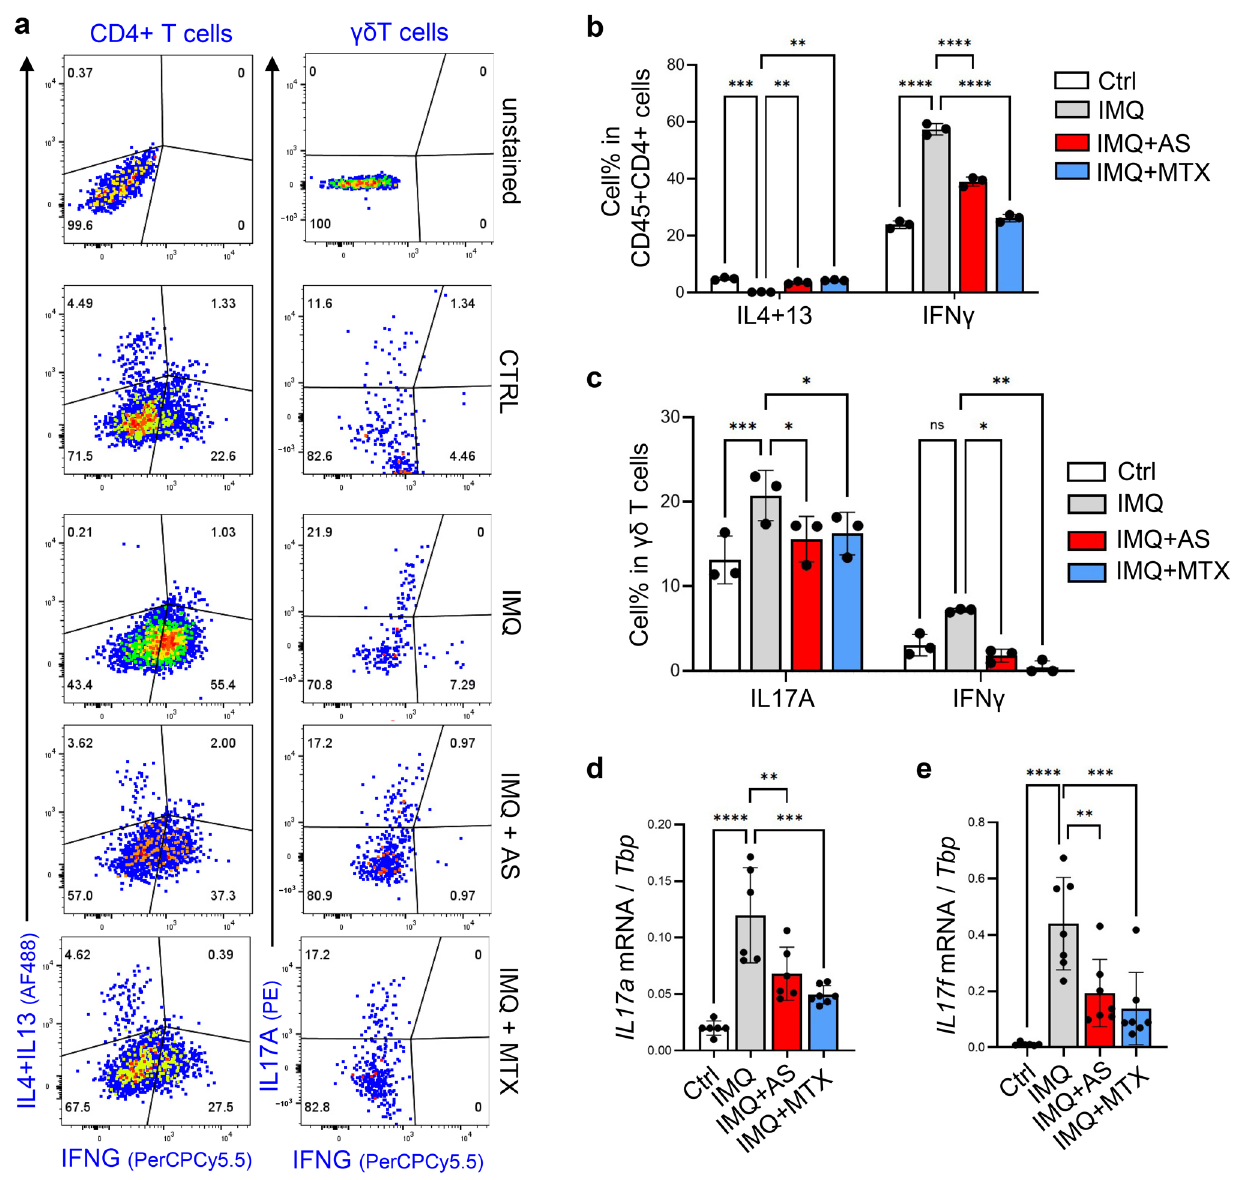
Figure 2. Administration of aluminum salt inhibited the development of Th1 and Th17 immune response in the IMQ-induced psoriasis model: ( a – c ) FACS plots ( a ) and quantified bar graphs ( b , c ) showing the percentage of IL4/IL13 + , IFN γ + or IL17A + cells in CD45 + CD4 + T cells ( b ) or CD45 + γδ T cells ( c ) in the skin ( n = 3/group); ( d , e ) qRT-PCR analysis of the mRNA expression levels of Defb4 and Defb3 (ratios to HK gene Tbp were shown, n = 6~7/group). All error bars indicate mean ± SEM, and statistical analysis was performed by two-way ANOVA with Bonferroni-corrected multiple comparisons ( b , c ) or one-way ANOVA analysis with Dunnett-corrected multiple comparisons ( d , e ). * p < 0.05, ** p < 0.01, *** p < 0.001, **** p < 0.0001, ns, non-significant.